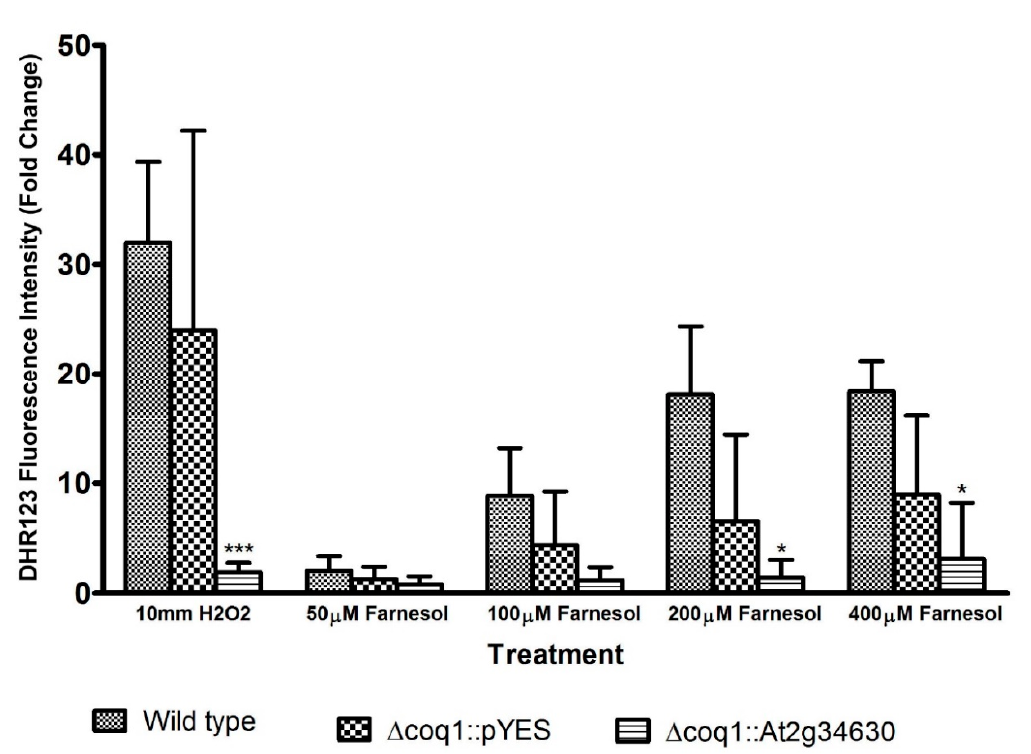
Figure 5. Reactive oxygen species (ROS) accumulation decreases with longer isoprenoid chain length. Flow cytometric analysis of ROS accumulation using DHR123 fluorescence intensity, expressed as the fold change (fluorescence / basal fluorescence with no farnesol or H 2 O 2 ). The data represent the mean ± standard deviation for three independent experiments. * = p < 0.05; *** = p < 0.001.